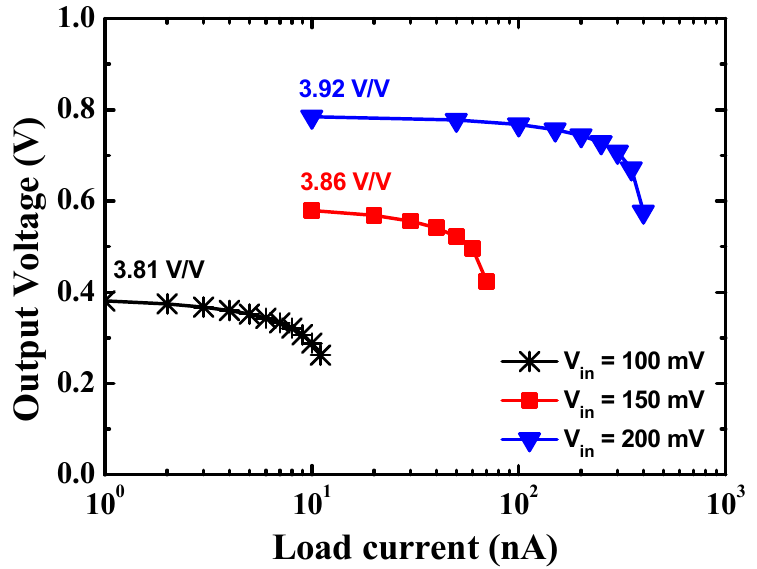
Figure 10. Output voltage according to the load current in different input voltages of the proposed charge pump.